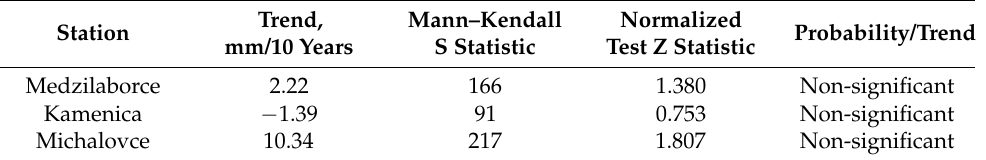
Table 3. Statistical characteristics of the meteorological data (1970–2019). Trend, Station